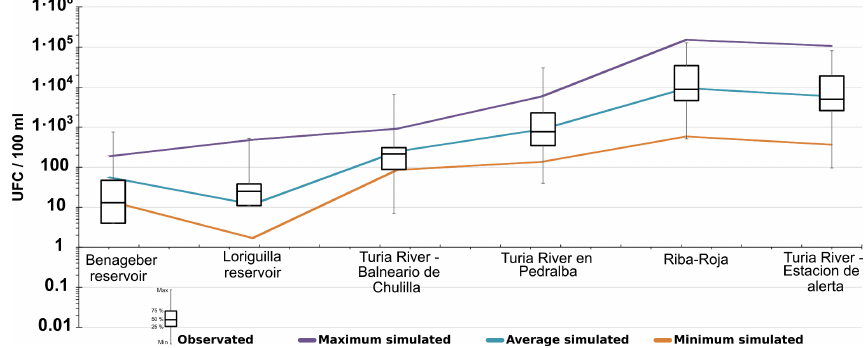
Figure 4. Adjustment between maximum, mean and minimum concentrations of TC observed and simulated along the Turia River.